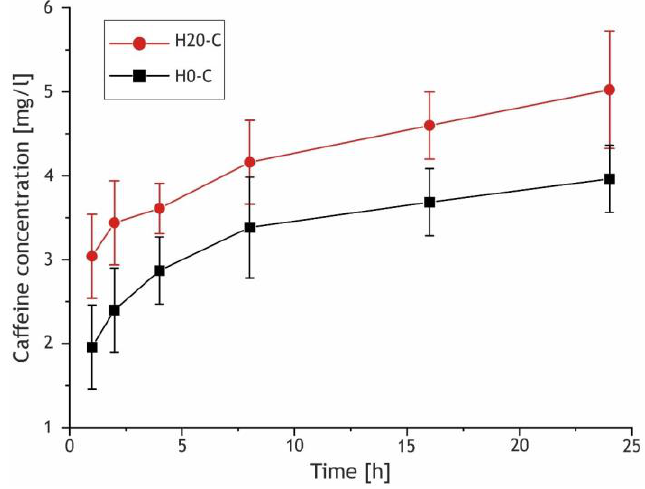
Figure 16. Caffeine release curves for the H20-C and H0-C samples (solid lines are for perception simplifying only).